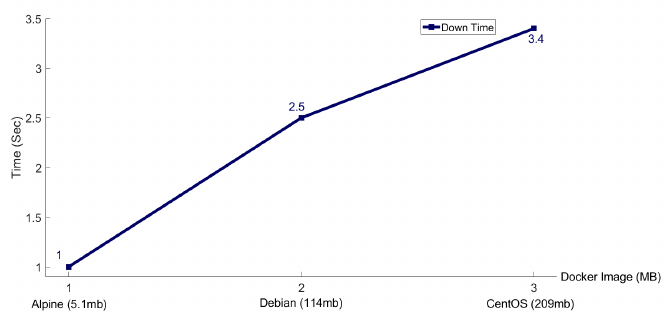
Figure 7. Comparison of download time with Alpine, Debian and